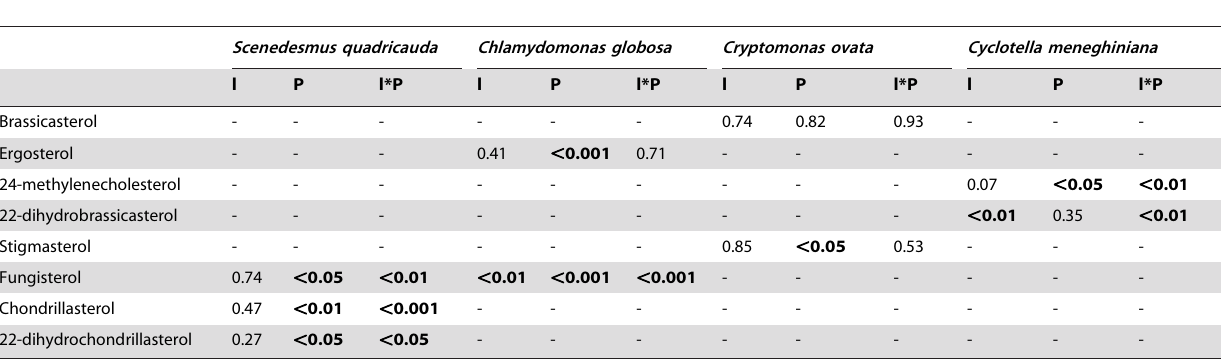
Table 1. P-values of ANCOVA for changes in sterol contents of four phytoplankton species, depending on the continuous variable light intensity (l, log e -transformed) and the factor medium phosphorus concentration